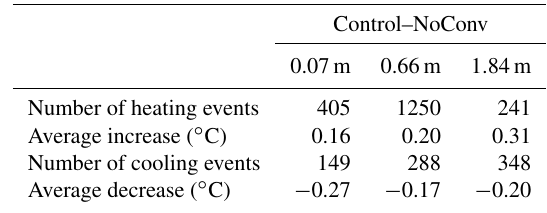
Table A1. The numbers of occurrences of heating and cooling CHT events and the average temperature deviations caused by CHT at 0.07, 0.66, and 1.84m depths at the QT08 site. The deviations of 0.1 ◦ C or less were excluded for